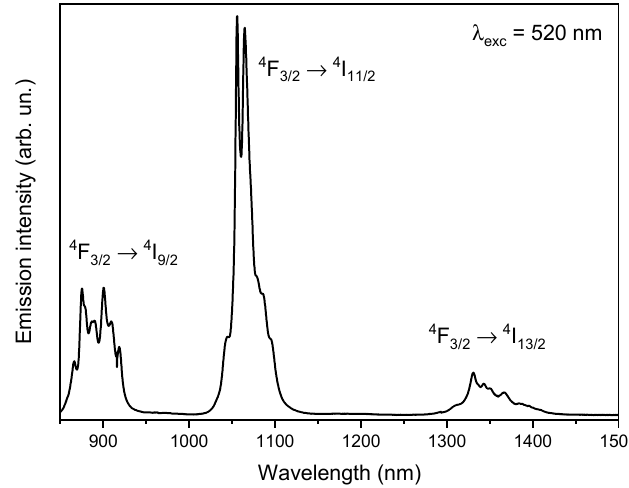
Figure 11. Emission spectrum of Ca 9 Nd(PO 4 ) 7 at λ exc = 520 nm.